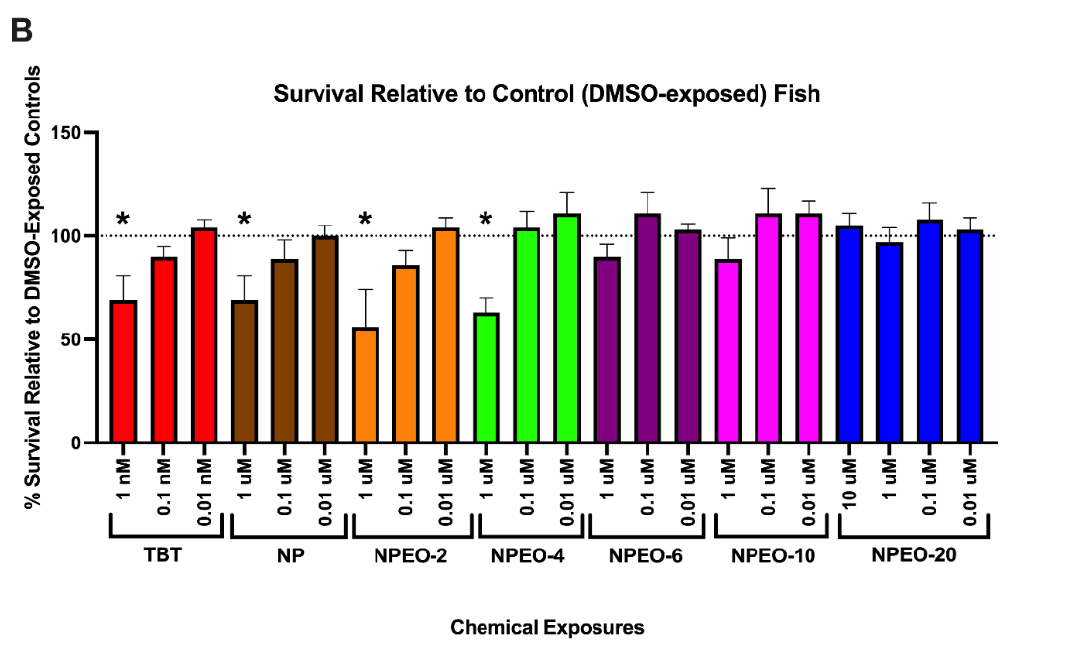
Figure 2. Lethality of nonylphenol and polyethoxylates in developmentally exposed zebrafish. Zebrafish were developmentally exposed to control chemicals, nonylphenol, or nonylphenol polyethoxylates from one through six days post-fertilization. Following exposures, fish were aged to 30 days post-fertilization. Lethality was measured twice daily to determine survivorship across test chemicals and treatments for each test chemical ( A ). n = 15 replicate fish in each biological replicate (spawning event) for each test chemical and concentration, and four spawns were performed (four biological replicates) and averaged for responses depicted here, for approximately 60 fish evaluated per experimental group. Lethality is depicted in survivorship curves, with decreasing response on the Y axis depicting greater lethality of the test chemicals. Survival percent relative to DMSO vehicle control exposed fish at 30 days ( B ). * indicates significant change in survival compared to vehicle control fish, p < 0.05, as per Kruskal–Wallis test with Dunn’s multiple comparisons. TBT 10 nM, NP 10 µ M, NPEO-2 10 µ M, NPEO-4 10 µ M, NPEO-6 10 µ M, and NPEO-10 10 µ M promoted absolute toxicity (no surviving fish) and thus are not depicted here for the purposes of clarity. DMSO = di- methylsulfoxide, vehicle control; TBT = tributyltin chloride; NPEO = nonylphenol polyethoxylated (with varying average ethoxylate chain lengths).